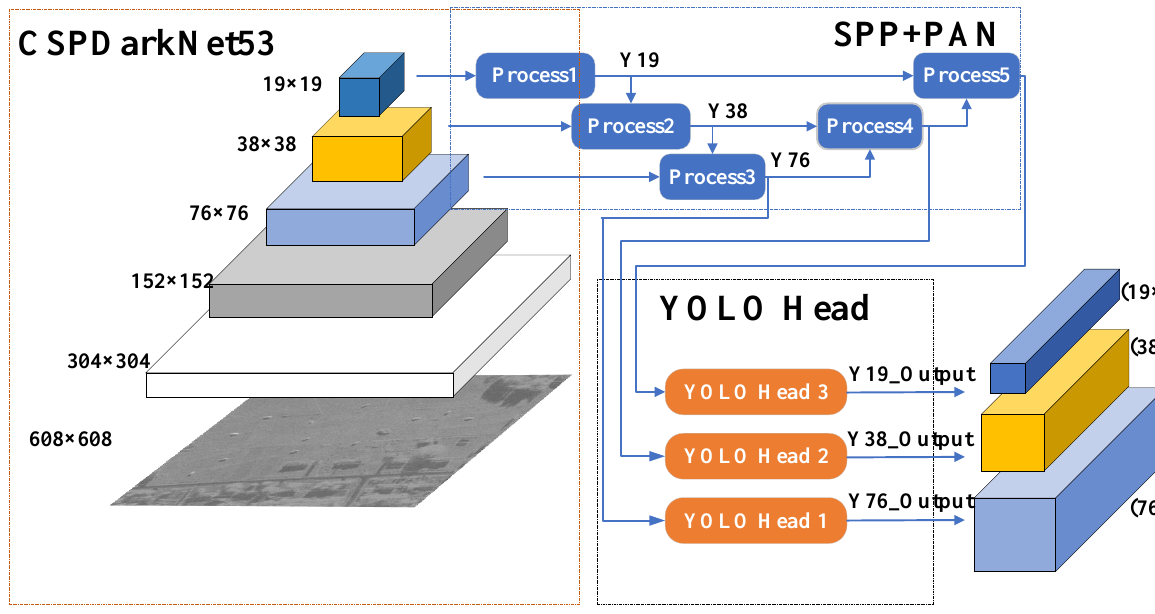
Figure 4. The architecture of YOLOv4 [13].